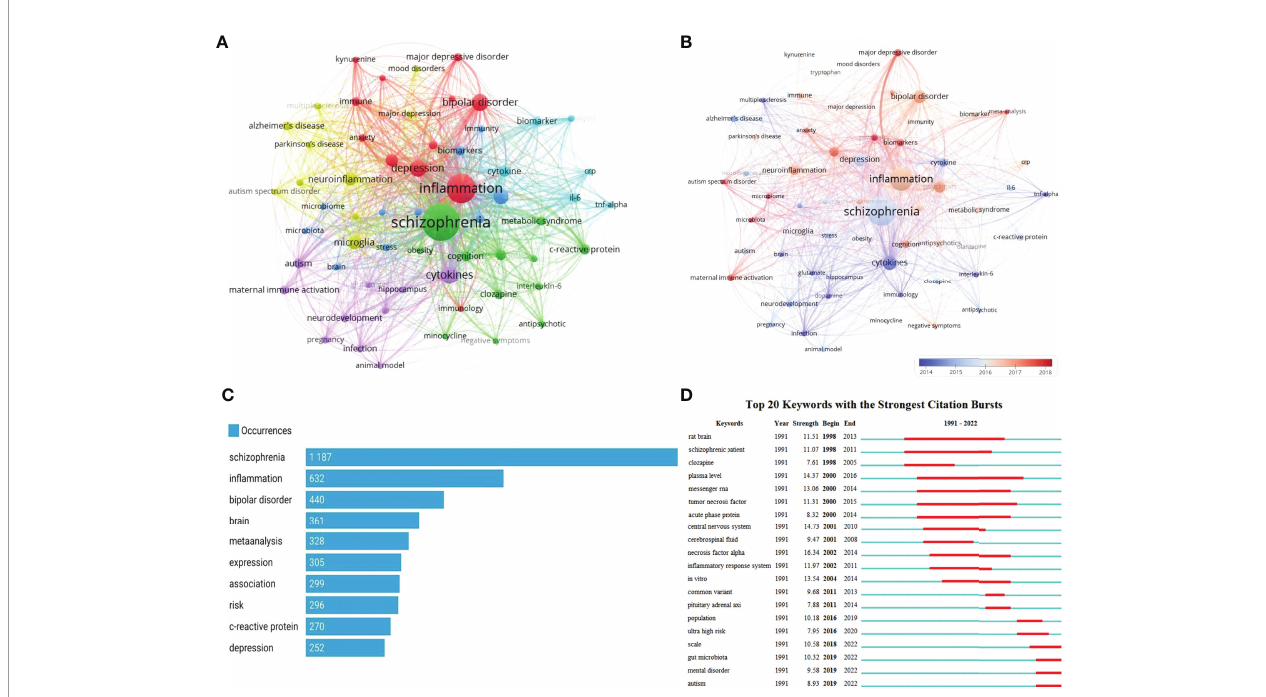
FIGURE 4 | Analysis of the research hotspots on schizophrenia and in fl ammation ( A , network visualization of author keywords; B , overlay visualization of author keywords; C , top 10 most frequent keywords; D , visualization map of top 20 keywords with the strongest citations bursts).